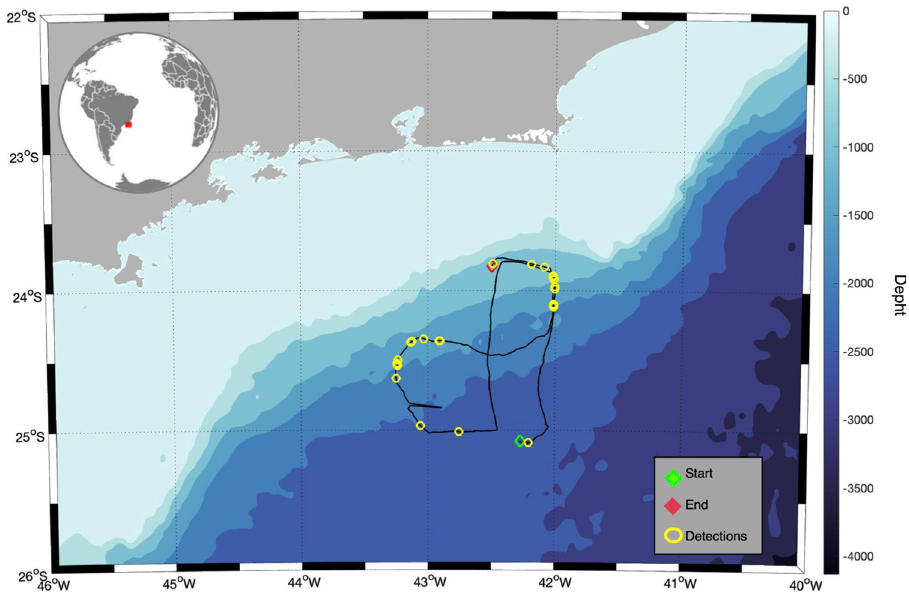
Fig 1. Map of the study area, the Santos Basin, showing the glider track on Brazilian offshore waters between November 12, 2015 (green marker) until December 19, 2015 (red marker). Yellow dots show the positions where Antarctic Minke Whales Bio-duck calls were